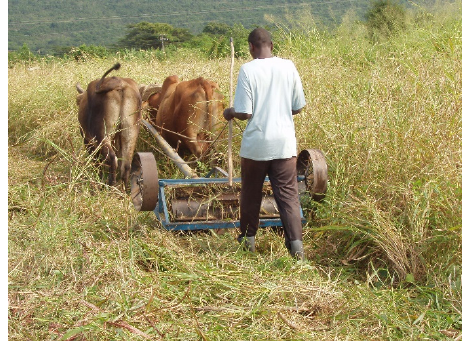
Figure 8. An animal ‐ drawn knife roller managing weed growth prior to direct seeding. Figure 8. An animal-drawn knife roller managing weed growth prior to direct